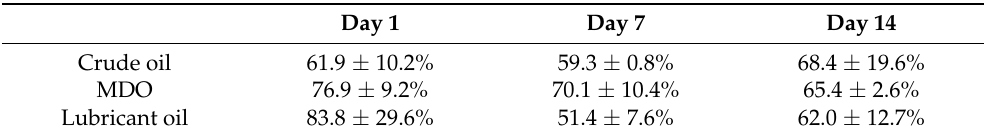
Table 5. Recovery of different kinds of oil from water surface and body after the experiment time periods day 1, 7 and